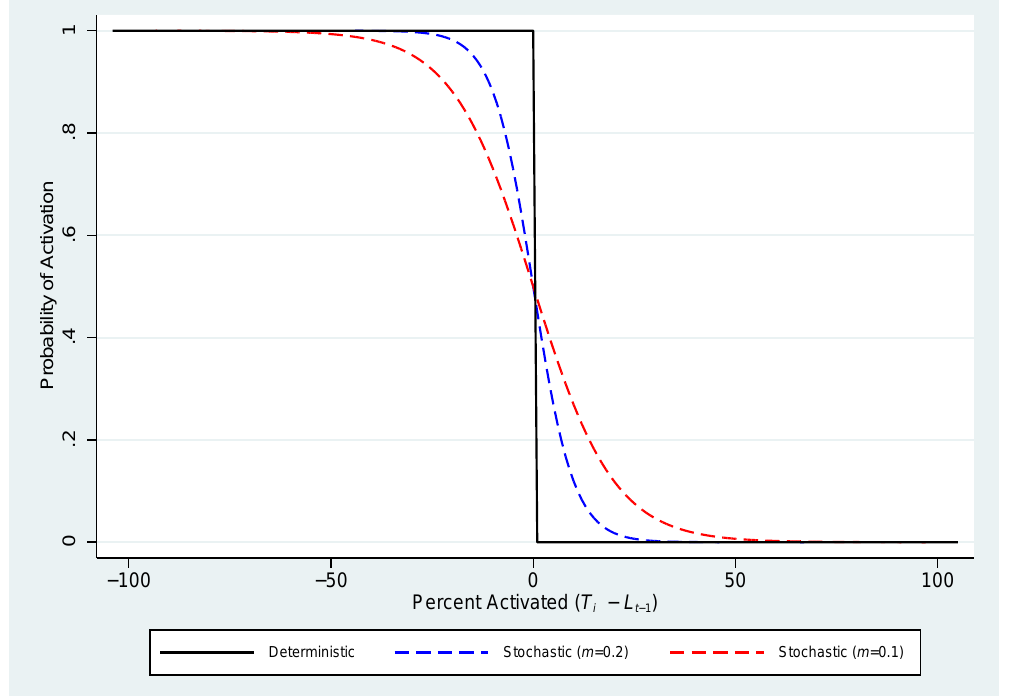
Figure 1: Deterministic and stochastic threshold functions. The solid line shows binary probabilities p = { 0, 1 } as a deterministic function of the group’s activation level L and individual threshold T , where L and T are the percentages of the group that are activated. The dashed lines show the continuous probability with stochastic thresholds with different slope parameters ( m = 0.1 in red and m = 0.2 in blue). The functions are nearly identical if L is far from T except that activation is always possible even if L >> T and activation can fail even if T >> L . These two errors offset each other, giving no increase in an individual’s expected activation. As L approaches T , the probability of an error increases exponentially up to a maximum p = 0.5 when L = T